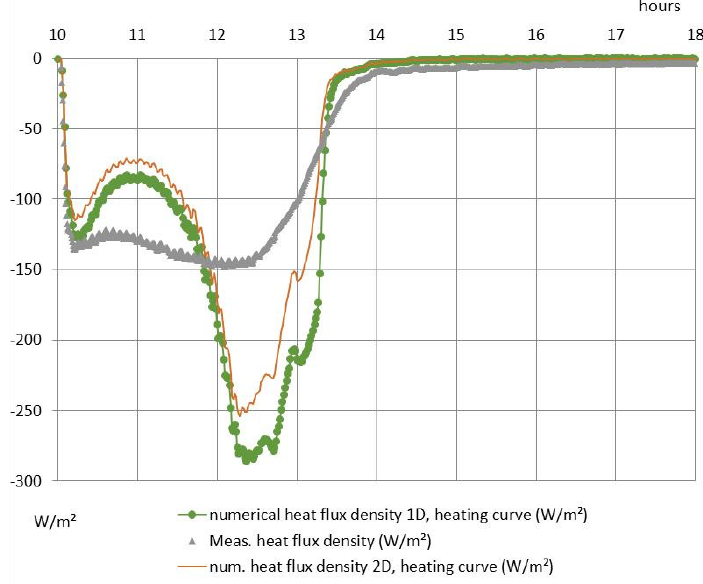
Figure 10. Comparison between 1D and 2D results for heat density to surface container. Heating case—heating heat capacity curve.